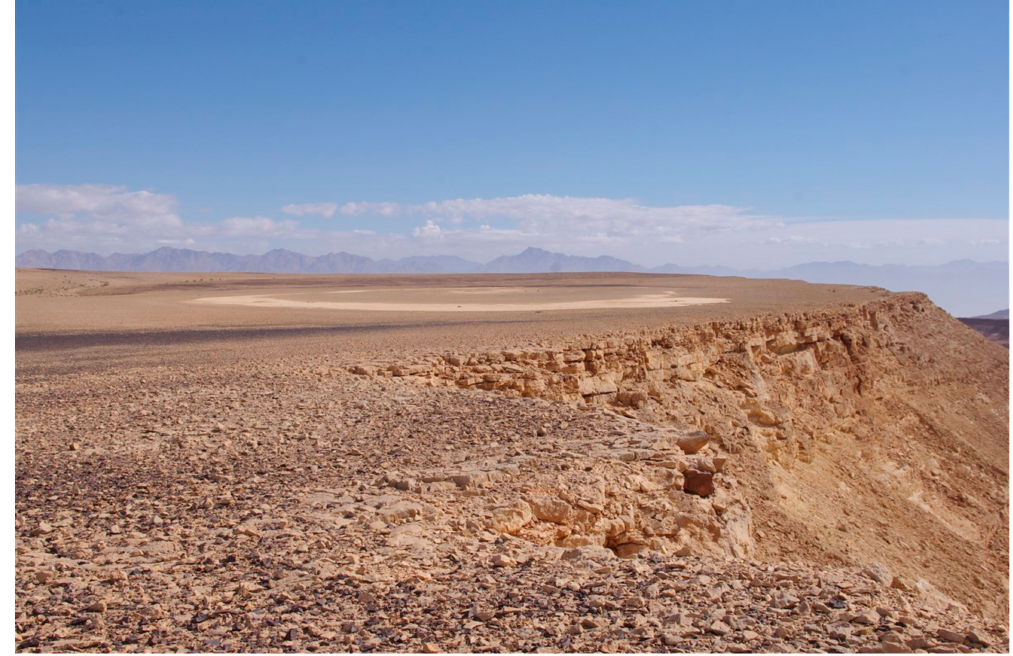
Figure 6. Se’ipim Playa (Qa Se’ipim), a southward sight. Notice the playa’s crescent shape. Picture taken by Ilan Stavi.